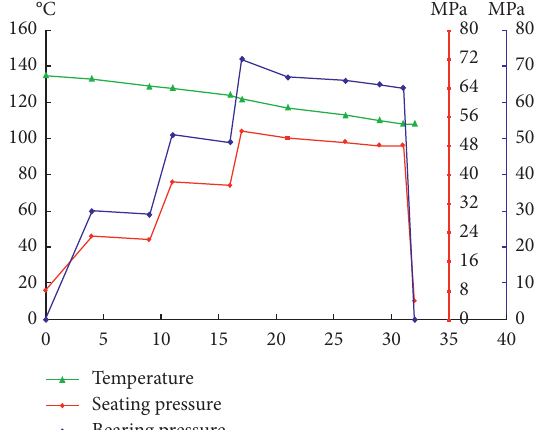
Figure 26: Change curve temperature, seating pressure, and bearing pressure.